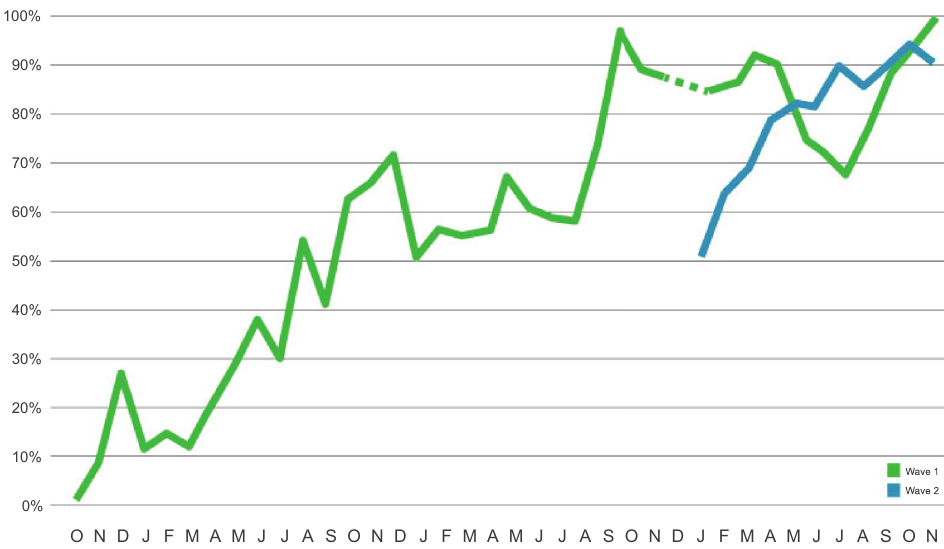
Figure 7. Niger: compliance with criteria for triage of children as part of the Integrated Management of Childhood Illness (IMCI). The rate of adoption of triage as part of IMCI was much higher in wave 2 than wave 1.